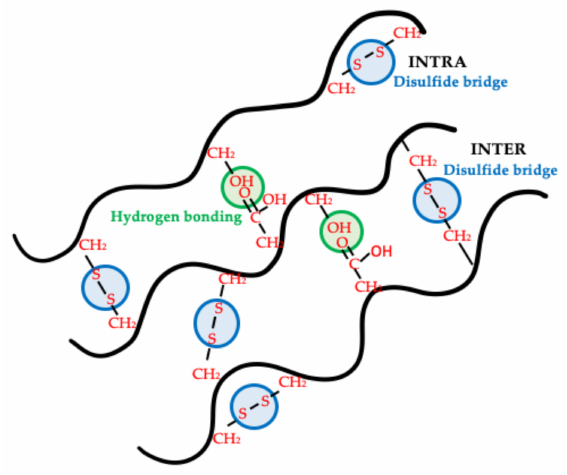
Figure 6. Proposed scheme for the main interactions promoted when protein unfolding takes